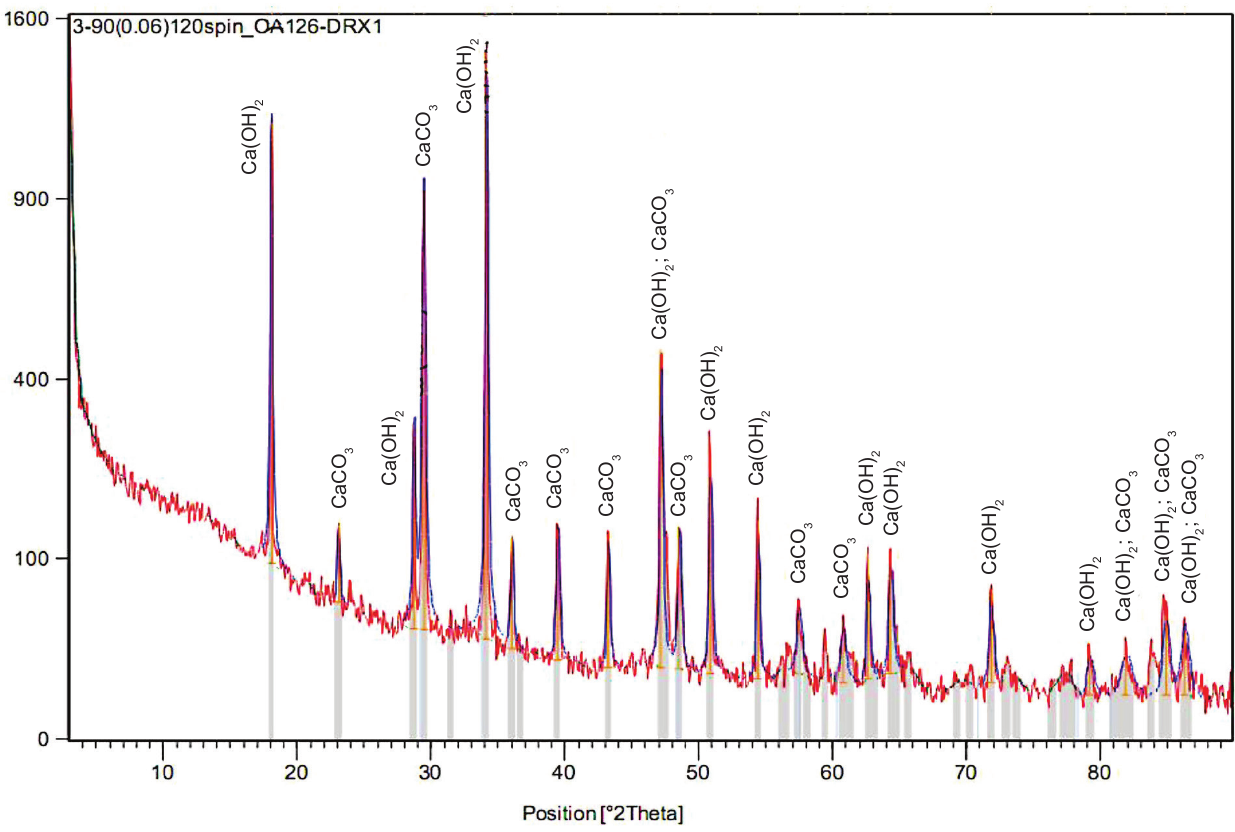
Fig. 1 – XRD spectrum of CES adsorbent